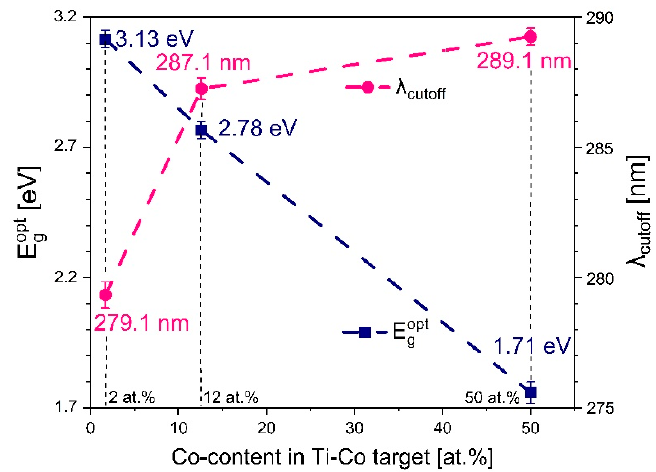
Figure 12. Influence of Co-content in the Ti–Co target on the optical band gap (E gopt ) and position of the optical absorption edge ( λ cutoff ) of (Ti,Co)Ox thin films.